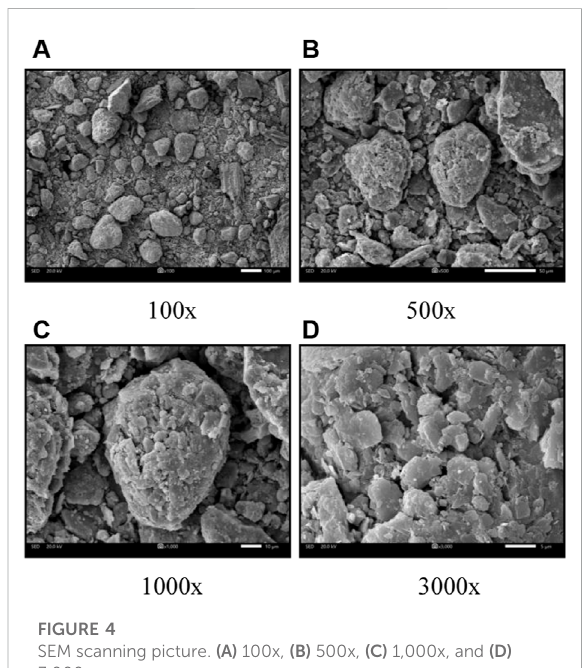
FIGURE 4 SEM scanning picture. (A) 100x, (B) 500x, (C) 1,000x, and (D)